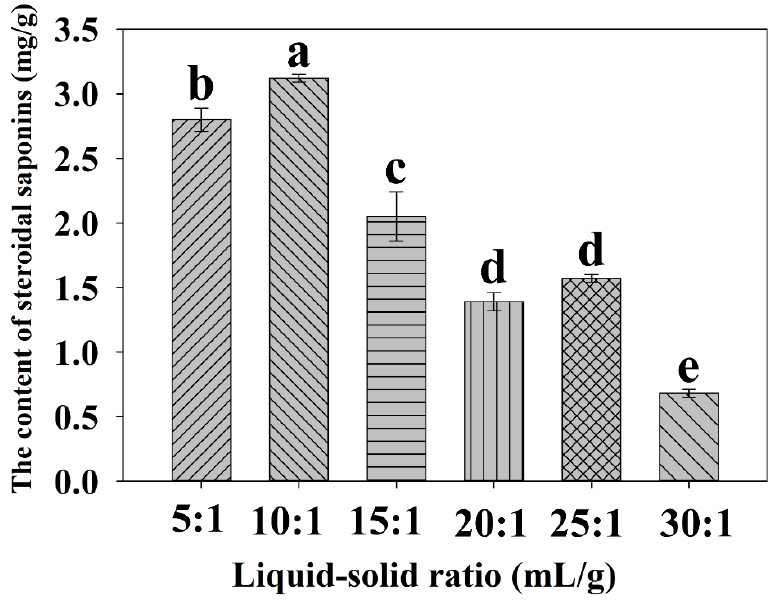
Figure 2. Effect of liquid-solid ratio on the yield of total steroidal saponins. Different lowercase letters represent the difference among treatments of liquid-solid ratios, p ≤ 0.05. Error bars indicate mean values ± SD, ( n = 3).